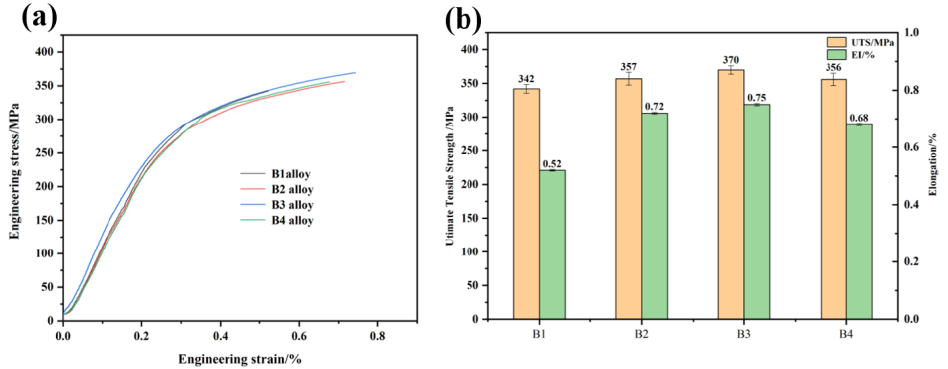
Figure 11. Tensile properties of Al-12Si-4Cu-2Ni-1Mg alloy at room temperature: ( a ) tensile curve; ( b ) tensile strength and elongation.